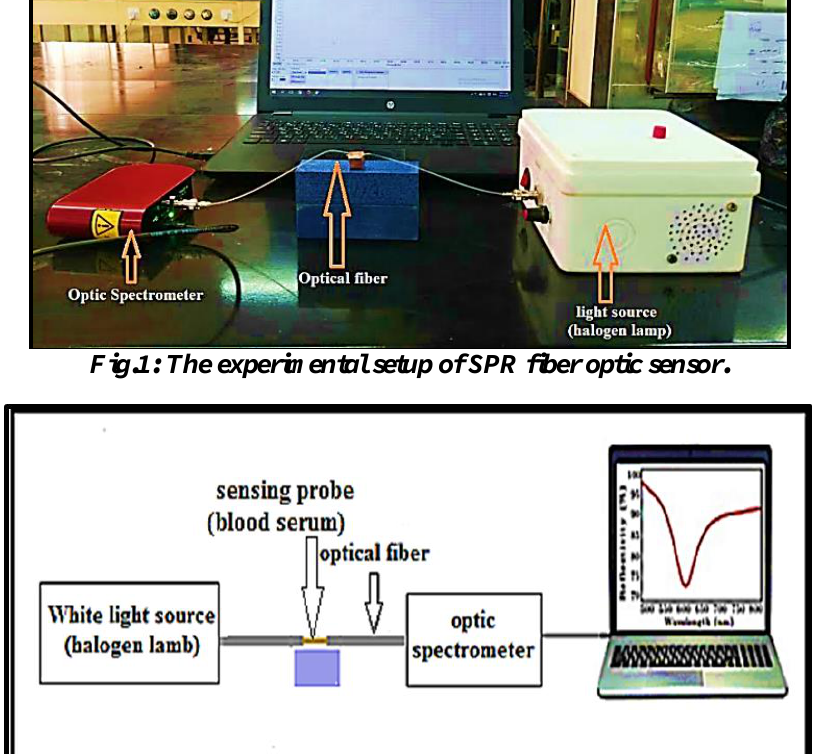
Fig.2: The outline of the experimental setup of SPR based on plastic optical